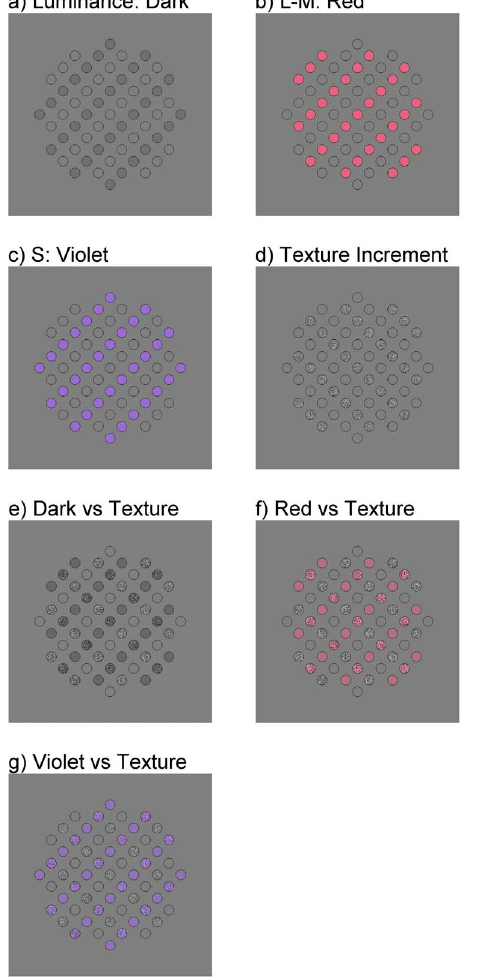
Fig. 1. Example stimuli. Panels a-d Separate condition: a) Luminance decrements (dark) are arranged on alternate diagonal rows of a 2D lattice of circles. b) L-M colour axis increments (red). c) S colour axis increments (violet). d) Texture increments. Panels e-g Combined condition: e) Luminance decrements on one axis of the diagonal lattice are paired with texture contrast increments on the orthogonal diagonal. f) L-M colour axis increments (red) paired with texture contract increments. g) S colour axis increments (violet) paired with texture contrast. Cue contrasts have been exaggerated for publication.